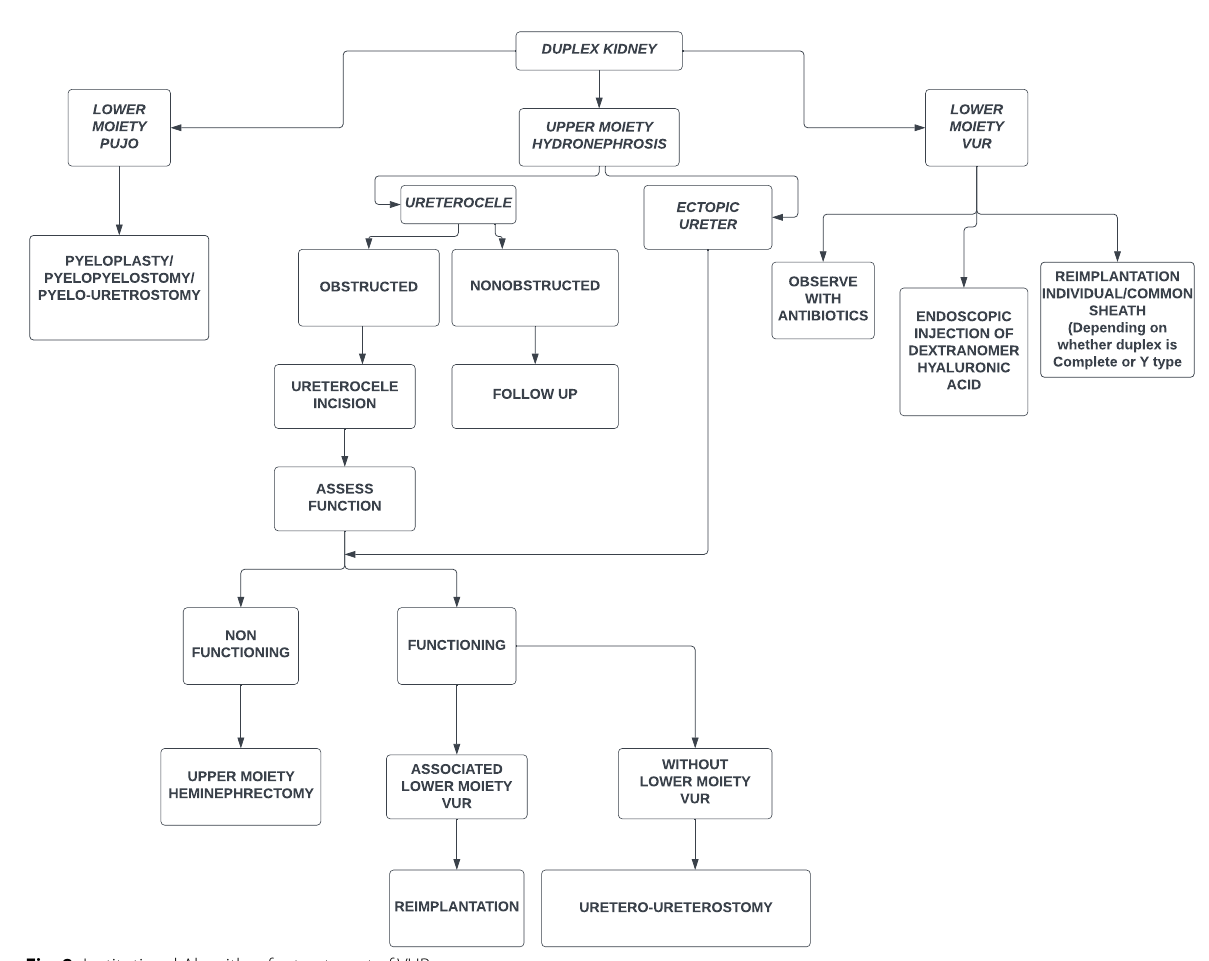
Fig. 8 Institutional Algorithm for treatment of